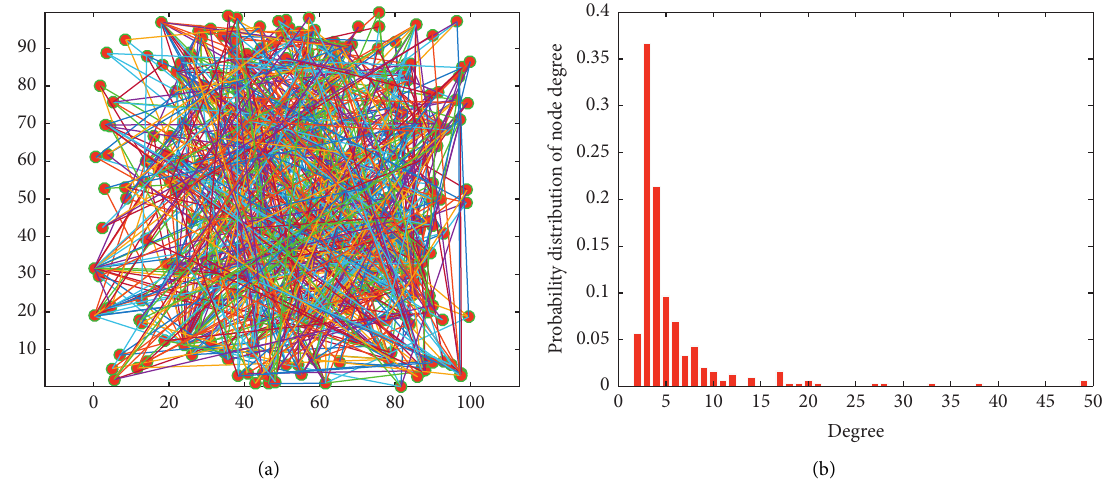
Figure 5: Schematic diagram of network structure. (a) Extended BA network structure diagram. (b) Probability distribution of node degree in network. Table 3: Parameter statistics of network structure corresponding to Figure 5. Average shortest Clustering coefficient Mean of degree path length